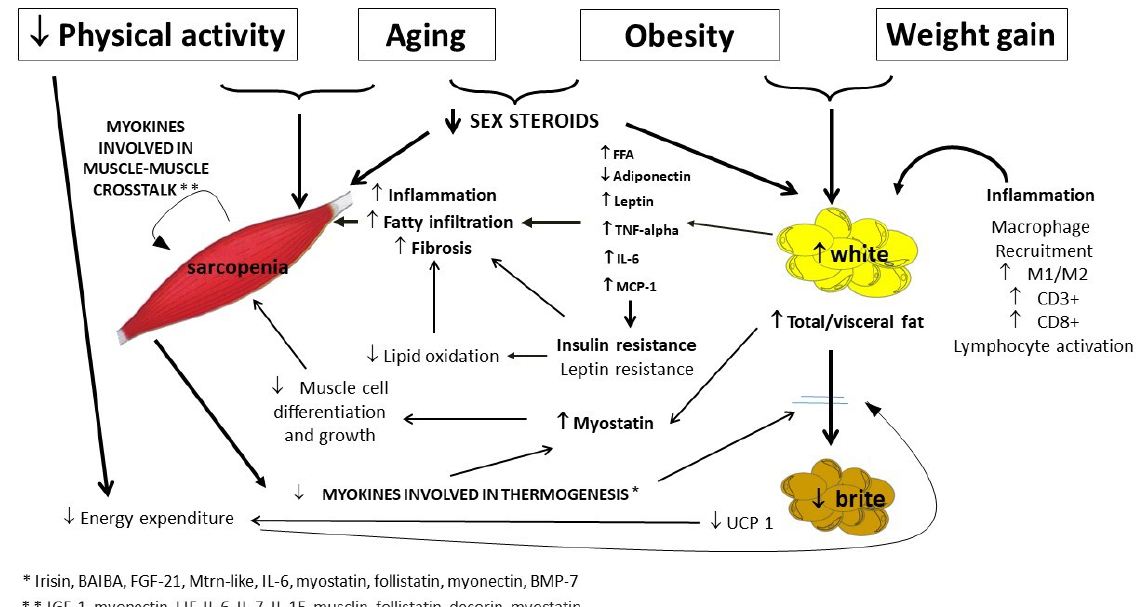
Figure 1. Main consequences of sarcopenic obesity in the elderly. CVD, cardiovascular disease.